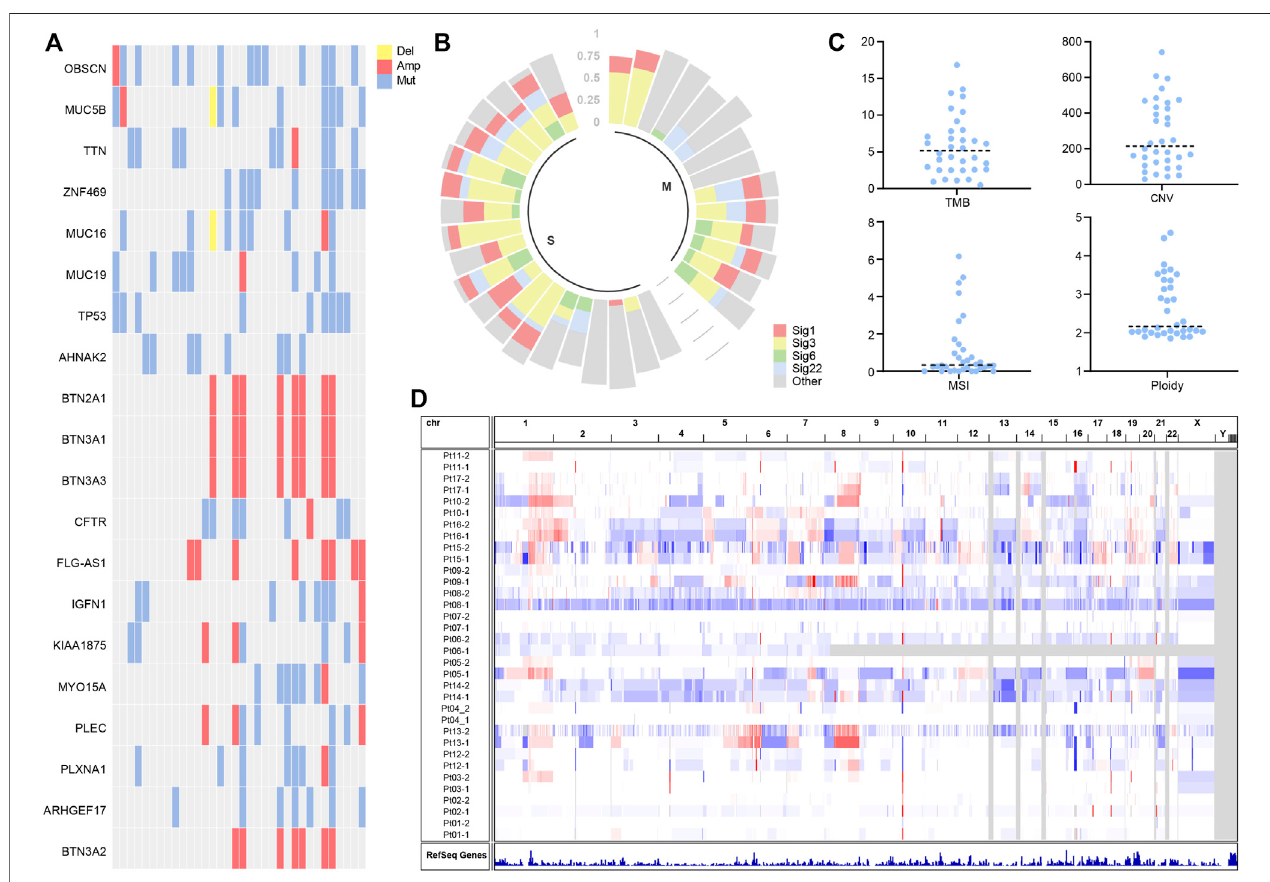
FIGURE 1 | (A) Landscapes of frequently mutated genes in liver cancer. (B) Mutation signature of liver cancer. (C) Characterization statistics of TMB, CNV, MSI, and Ploidy. (D) Copy number alterations in liver cancer.